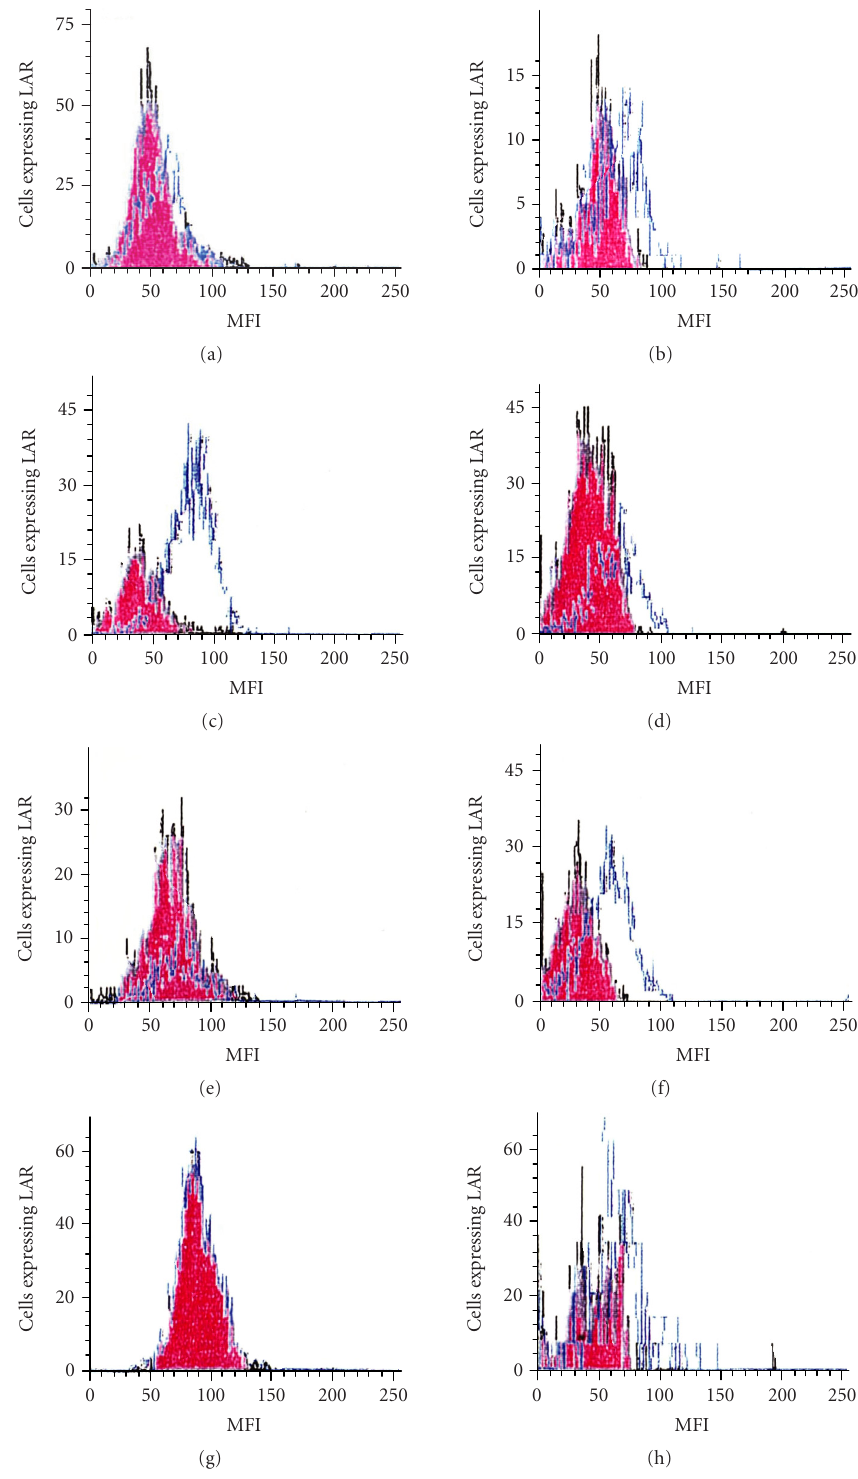
Figure 2. Flow cytometric histogram profiles of LAR expression in (a), (c), (e), (g) CD3 + (positive) cells and (b), (d), (f), (h) CD3 − (negative) cells, reflecting isolation periods, 30, 60, 90, and 120 minutes. The shaded histograms on CD3 + and CD3 − cell populations represent the expression of the anti-KLH antibody, and the open histograms in the CD3 + and CD3 − cell populations represent the expression obtained with the anti-LAR antibody. Note: anti-KLH and anti-LAR expressions in the CD3 + cells have moved from 0 to 50 on the forward scatter axis (g). Nonspecific uptake of the antibody due to the length of incubation, or a population of lymphocytes with di ff erent phenotypic characteristics may explain this result. These results are representative of three experiments. MFI denotes mean fluorescence